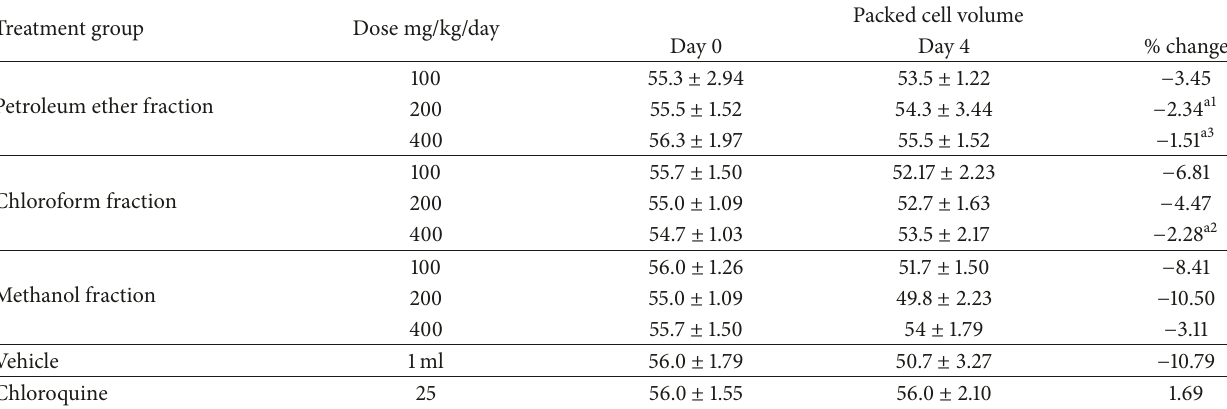
Table 5: Effect of the solvent fractions of Carica papaya root on PCV, body temperature, and weight of P. berghei infected mice on 4-day Peter’s suppression test.